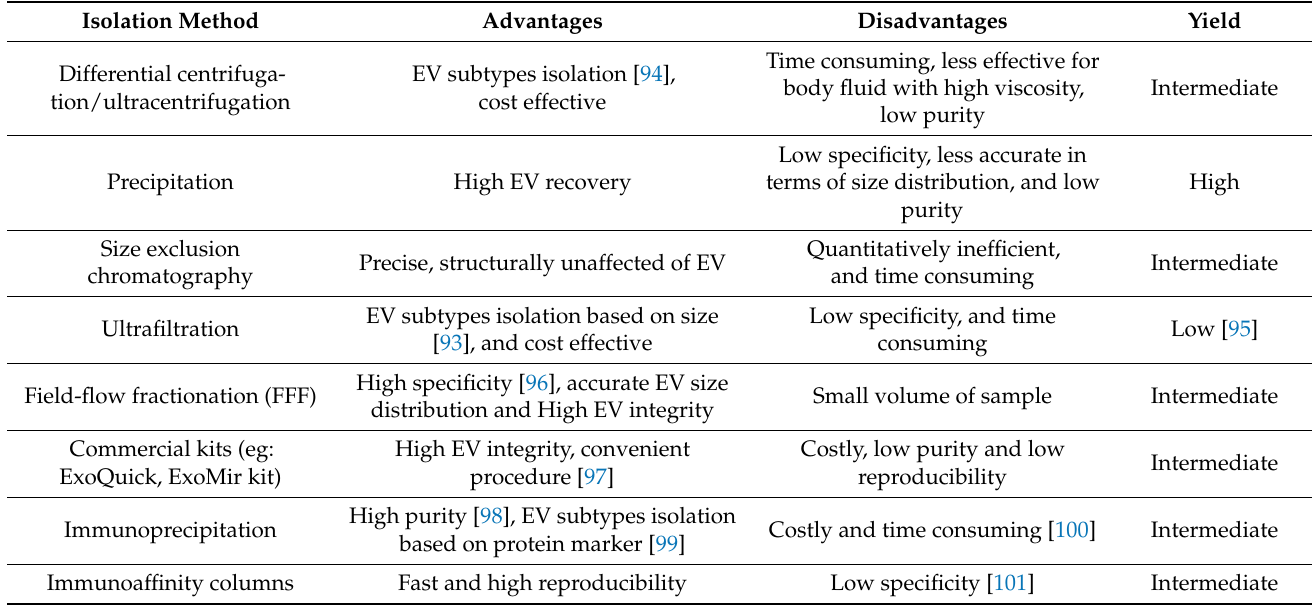
Table 1. Advantages and disadvantages of EV isolation